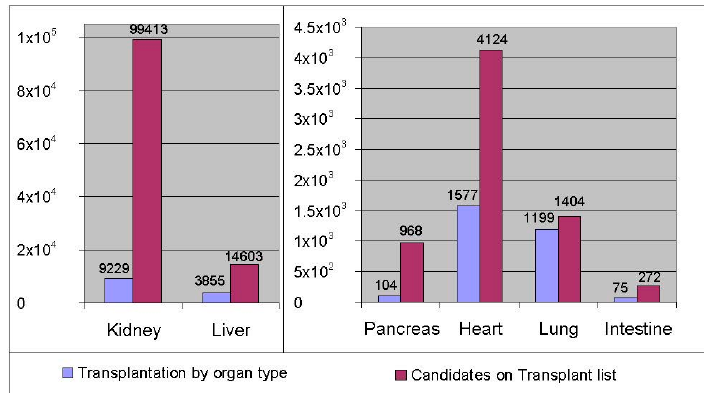
Figure 1. Transplantation procedures for various organ types performed in January–June 2016 in comparison to the number of candidates on the transplantation list as of 29 July 2016. The disparity between organ supply and demand is striking, particularly for kidney, liver, and pancreas. Data adopted from UNOS [1]. These synthetic and natural platforms exist along a broad spectrum of technologies encompassed by the field of regenerative medicine. They are discussed further in subsequent sections. The spectrum includes cellular therapies utilizing allogeneic, autologous or xenogeneic cells; technologies reliant on cells that are integrated into extracorporeal or implantable devices; and